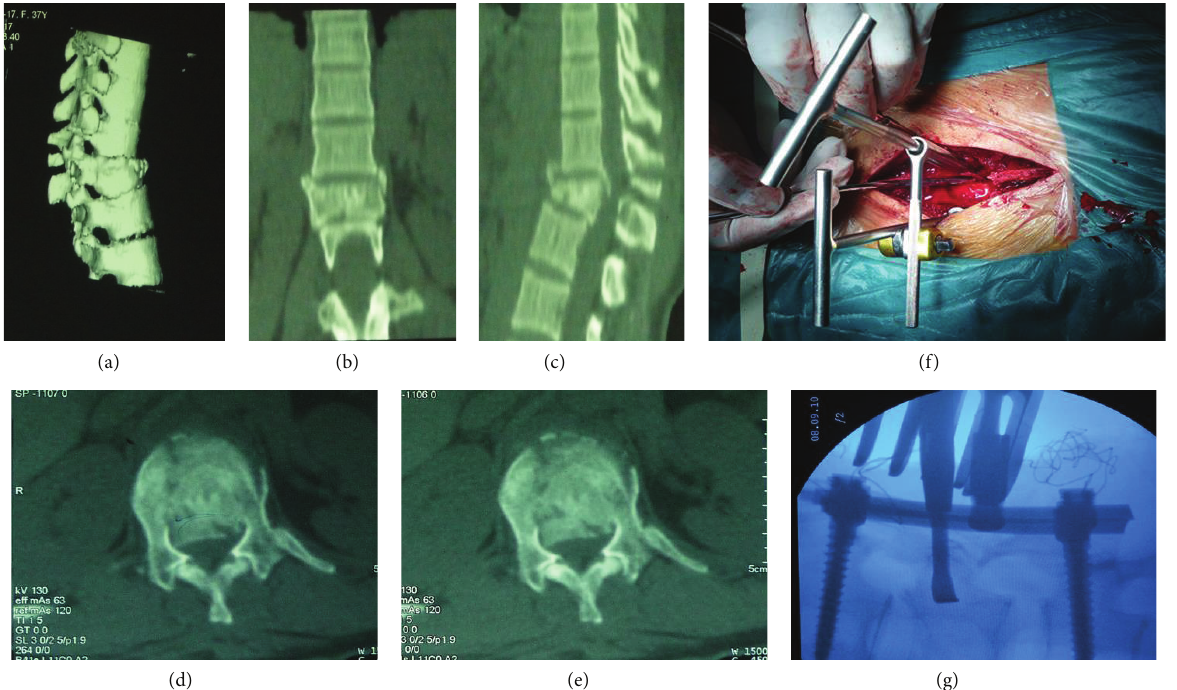
Figure 2: (a)–(e) The preoperative CT scan image demonstrating a significant spinal canal encroachment by retropulsed bone fragments. (f)-(g) The intraoperative application of RRBF and the fluoroscopy of restoration of fractured vertebral body.